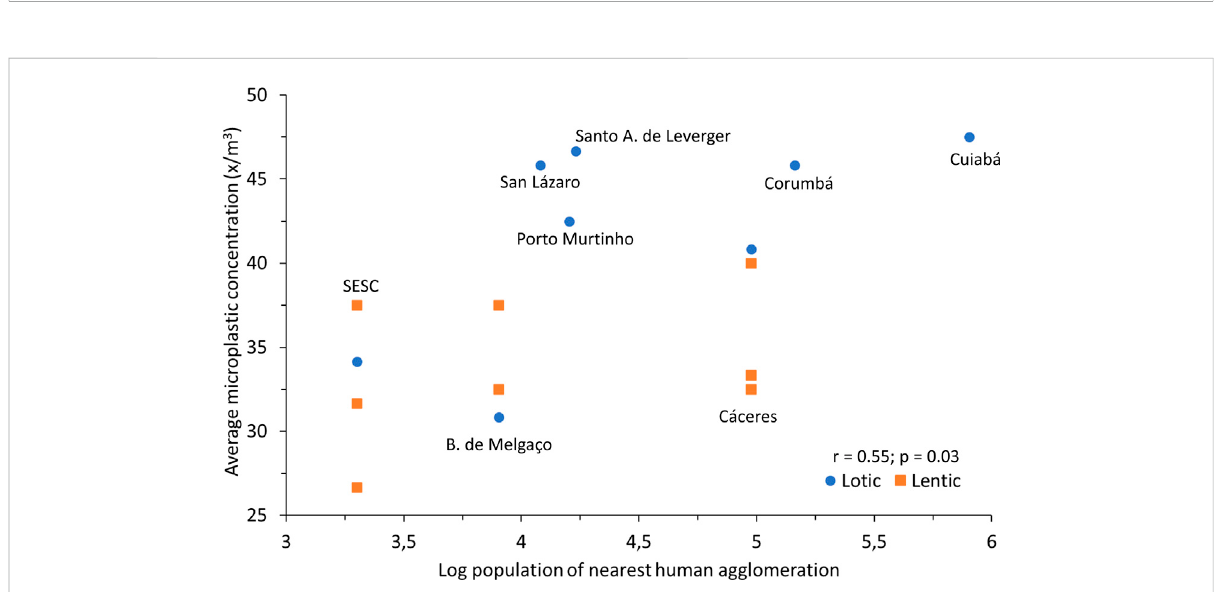
FIGURE 4 Correlationbetweentheaverageconcentrationofmicroplasticsandthepopulationofthenearestcity/humanagglomeration(inLog 10 ).Thecorrelation coef fi cient (r) and the signi fi cance probability (p) are also given. For each sampling site, the nearest human agglomeration is indicated. When more than a sampling site is closest to the same nearest human agglomeration, the name of the agglomeration is indicated above or below. The legend also indicates whether the sampling site is under lotic or lentic fl ow conditions. More information about human agglomerations can be obtained in Table